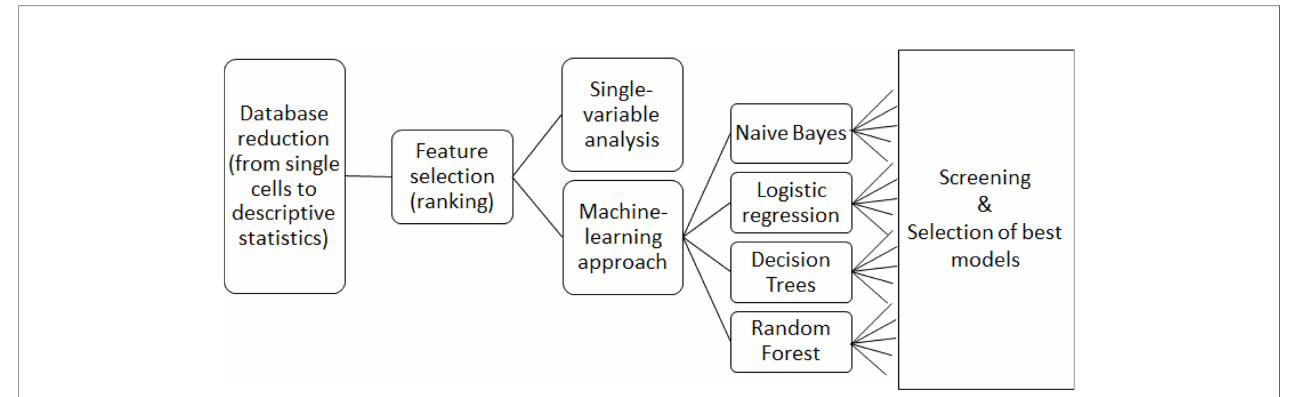
FIGURE 1 | Overview of data analysis work fl